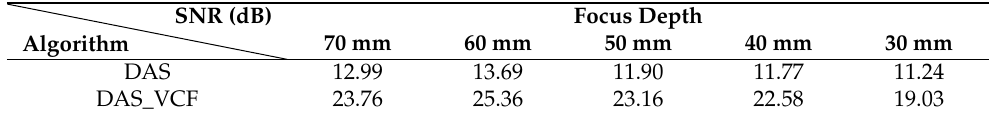
Table 4. SNR of cracks with DAS and DAS_VCF algorithms.